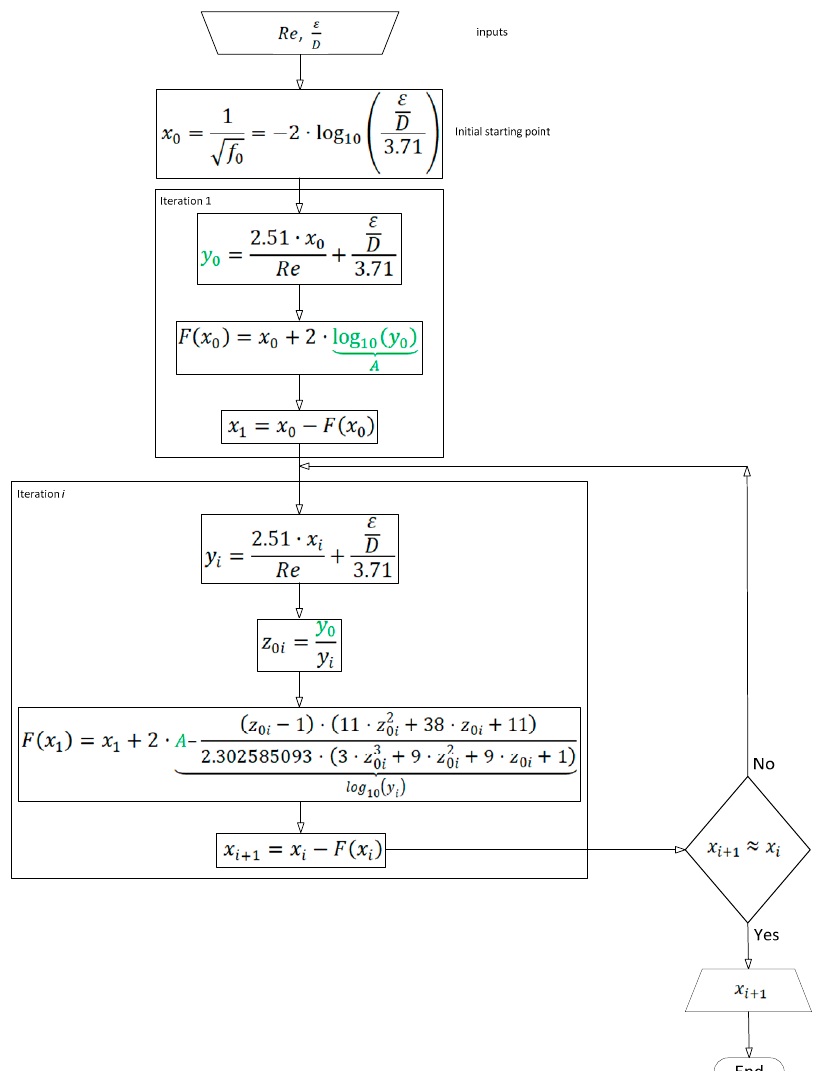
Figure 2. A possible procedure for solving the Colebrook equation using Padé approximants and the simple fixed-point iterative method.